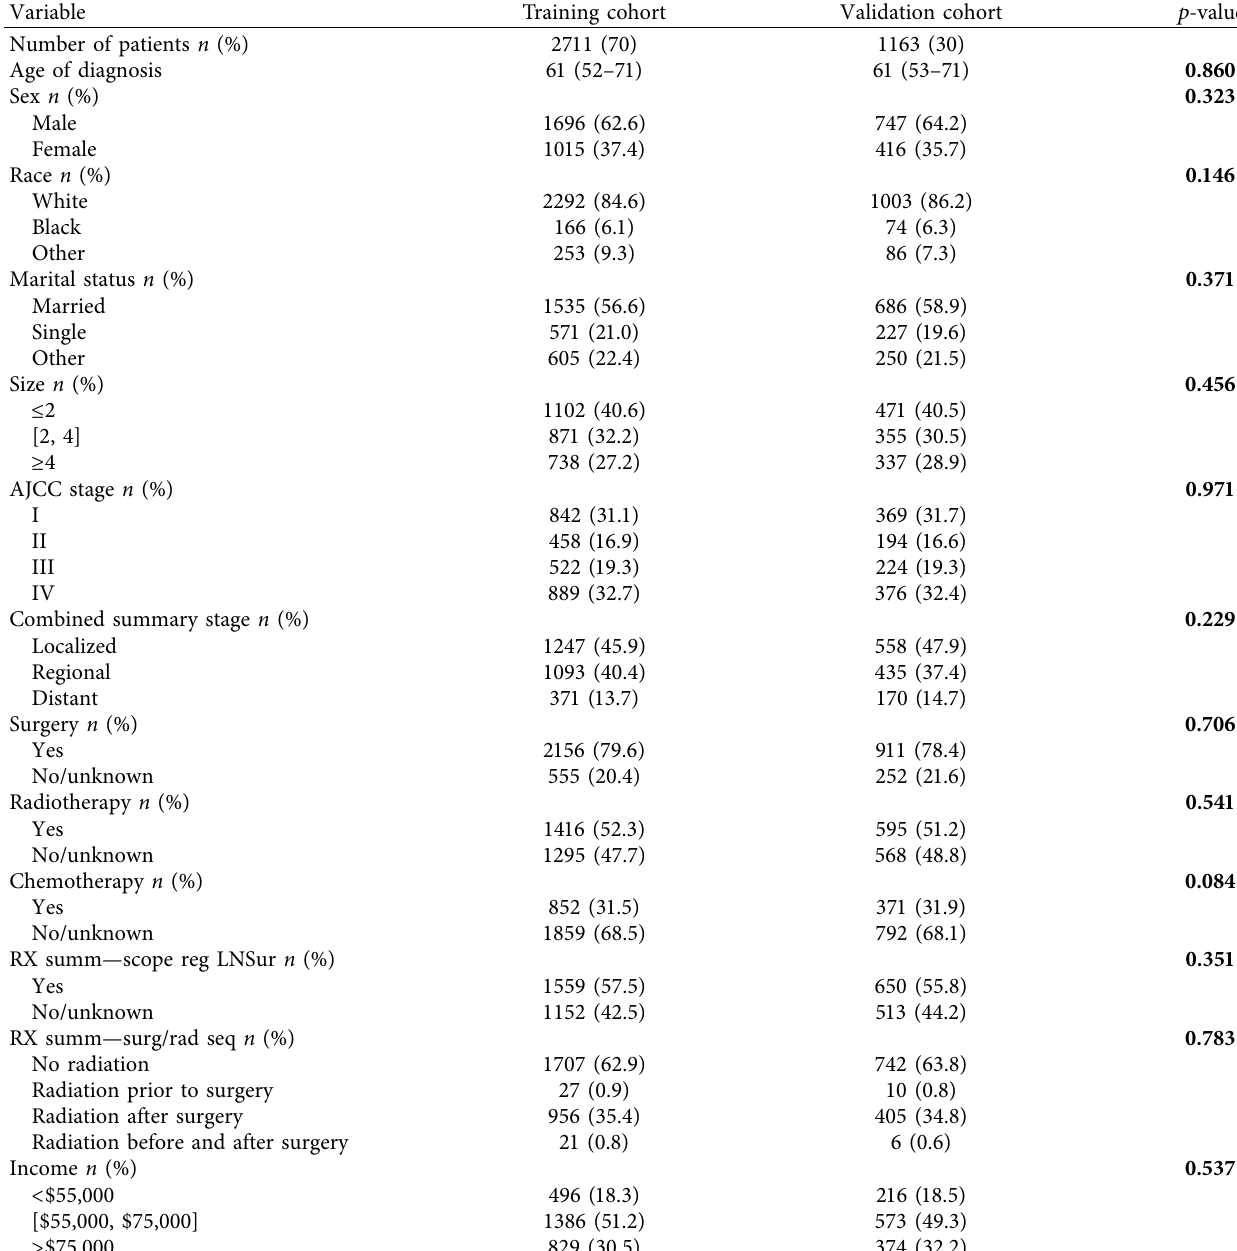
Table 1: Lists the basic information for the two